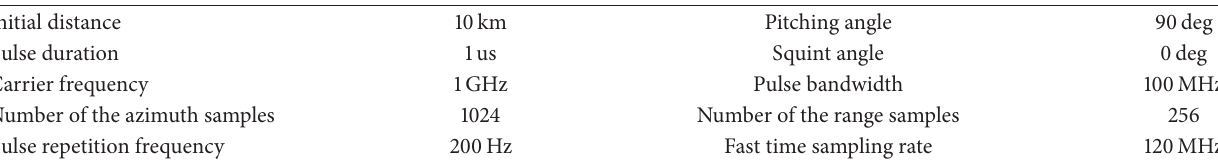
Table 1: Simulation